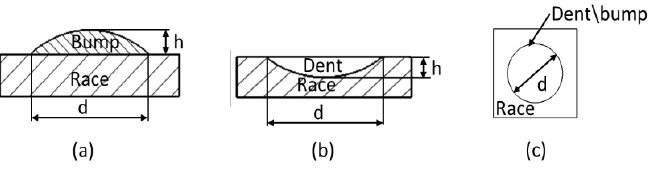
Figure 2. ( a ) Cross-section of bump defect, ( b ) cross-section of dent defect, ( c ) and top view of bump and dent defect.